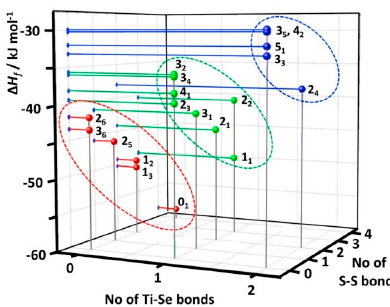
Figure 6. Enthalpies of formation of the [TiCp 2 Se x S 5 − x ] complexes as a function of the number of Ti–Se and S–S bonds. Complexes with two Ti–Se bonds have been marked in blue, those with one Ti–S and one Ti–Se bond in green, and those with two Ti–Se bonds in red.